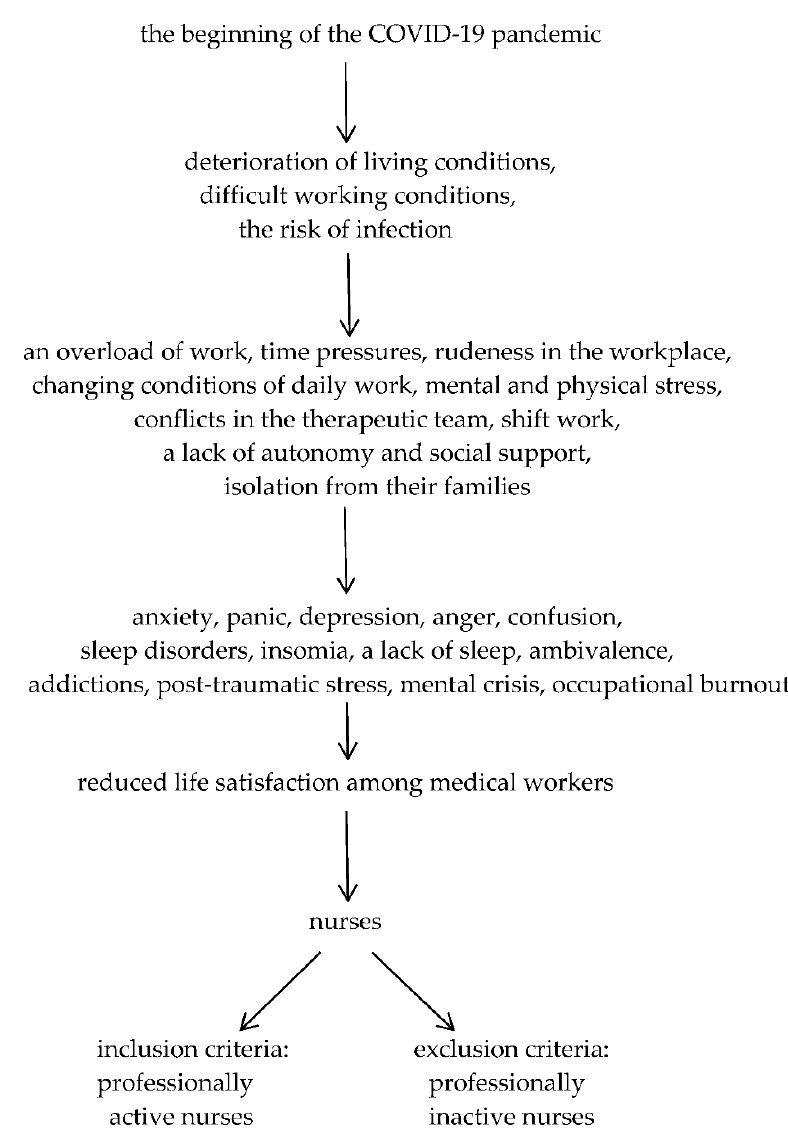
Figure 1. Study Figure 1. Study design.